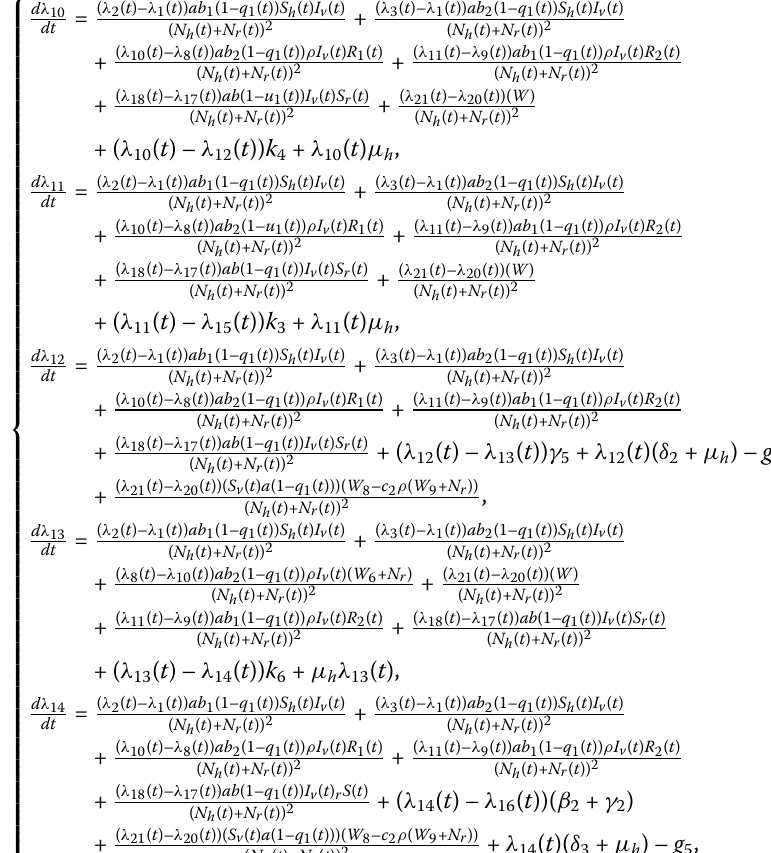
Figure 11 Comparison of behaviors with and without control in case of Z r and S v